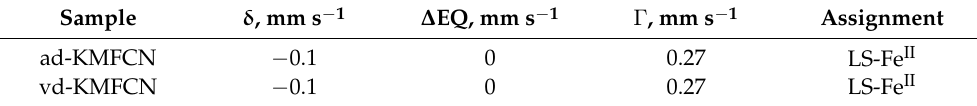
Figure 4. 57 Fe Mössbauer spectra of ( a ) ad-KMFCN and ( b ) vd-KMFCN samples at 298 K. Table 2. Isomeric shift, δ ; quadrupole splitting, ∆ EQ; and linewidth, Г of ad- and